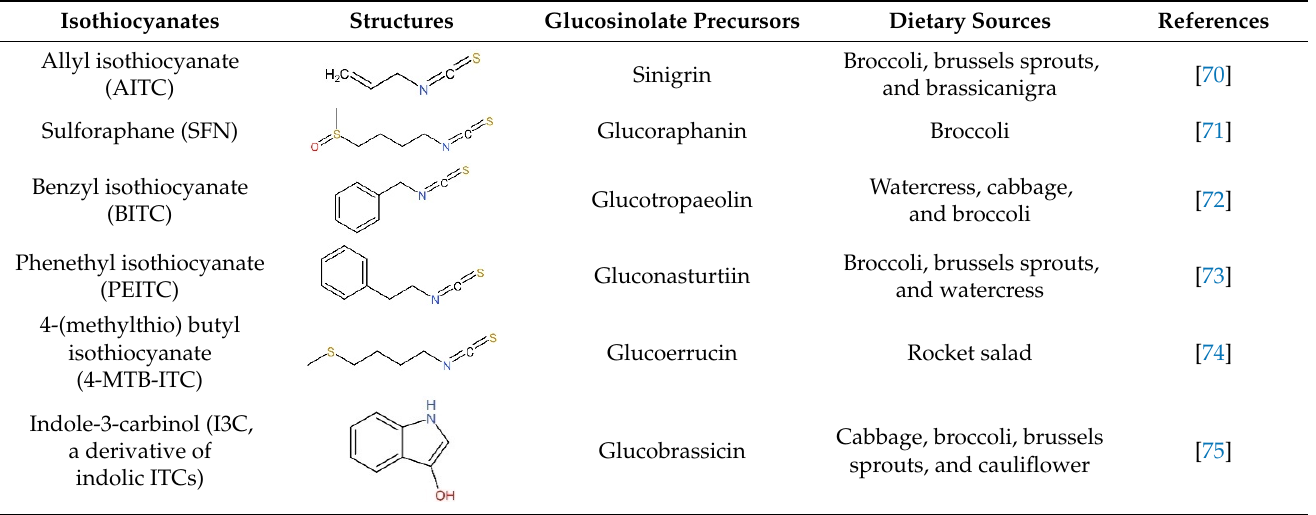
Table 1. Information on dietary sources of isothiocyanates and their glucosinolate precursors.